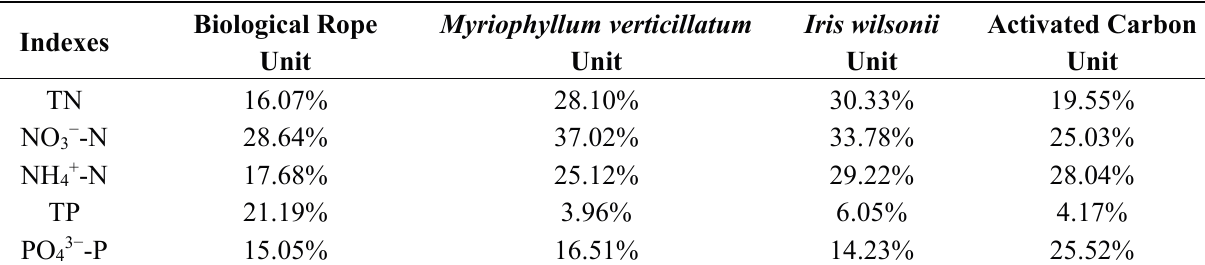
Table 1. Net removal rate of each